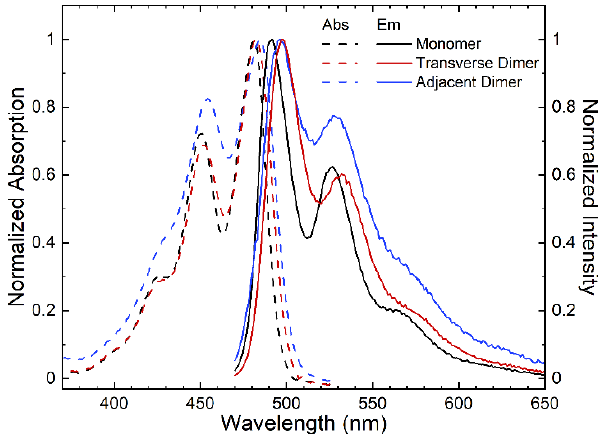
Figure 1. Steady-state absorption and fluorescence emission spectra of DNA-templated perylene monomer (black), transverse dimer (red) and adjacent dimer (blue) solutions. The absorption and fluorescence emission spectra are plotted with dashed and solid lines, respectively, and are normalized to their corresponding most intense absorption and fluorescence emission bands. Table 1. Steady-State Absorption and Fluorescence Emission Characterization of DNA-Templated Perylene Monomer and Adjacent and Transverse Dimers.